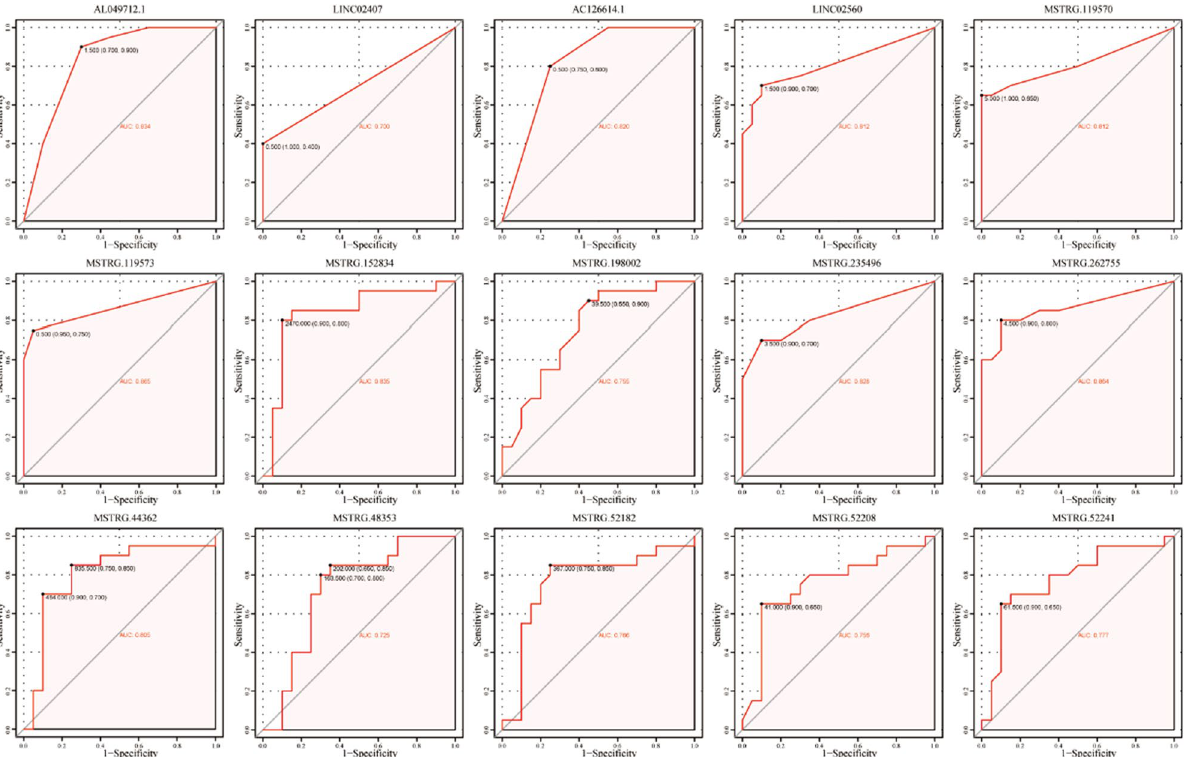
Figure 6. ROC curve analysis of key lncRNAs (n = 15) identified based on hub genes. ROC curve analysis of the 15 key lncRNAs shows good discrimination between cancer and cancer-adjacent tissues from patients with